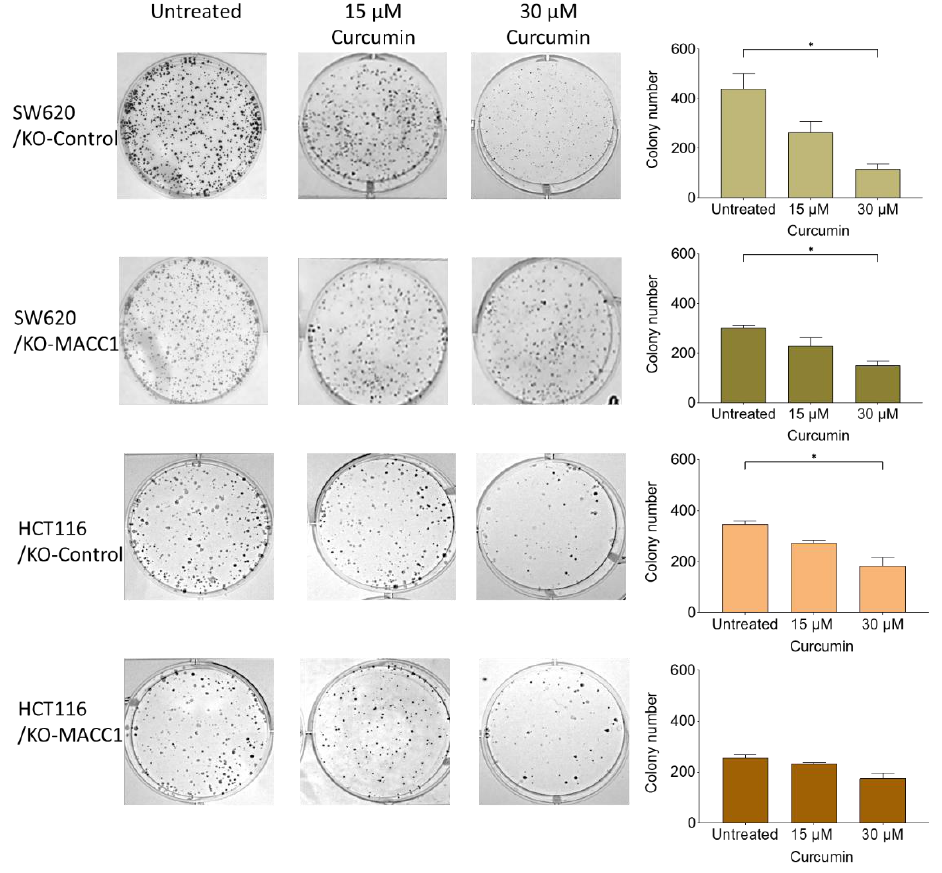
Figure 4. Curcumin reduces MACC1-mediated clonogenicity. 400 cells/well were seeded into 6-well plates and were treated with various curcumin concentrations. After 10 days, the cells were fixed and stained with crystal violet. Afterward, the cells were imaged, and the colony numbers were assessed. Data represent mean ± SEM ( n ≥ 3), * = p < 0.05.